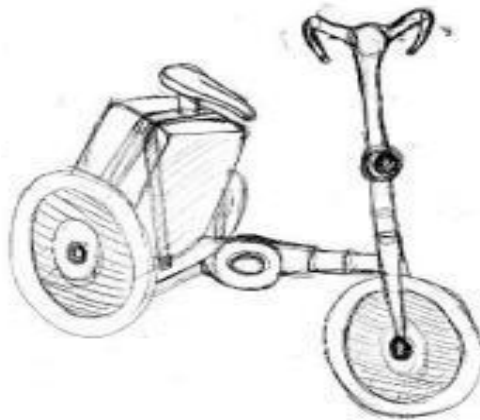
Figure 9. Advanced style.